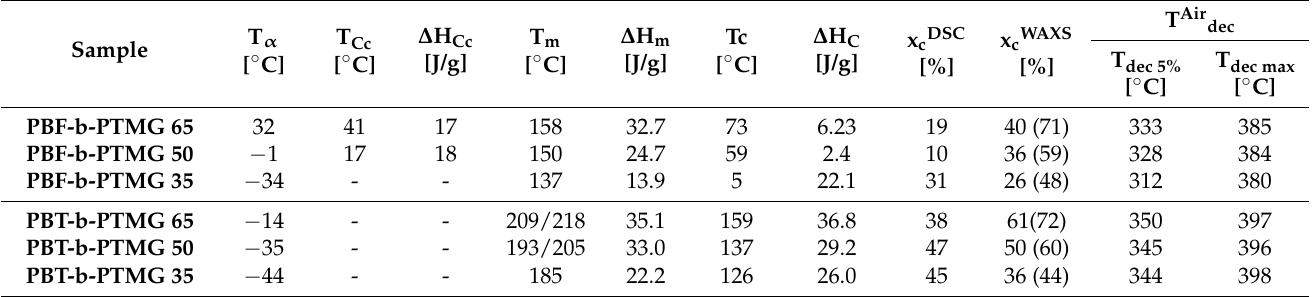
Figure 4. DSC thermograms of investigated copolymers: ( a ) cooling, ( b ) 2nd heating cycles, rate 10 ◦ C/min. Table 2. Thermal parameters and degrees of crystallization determined for PBF and PBT copolymers.